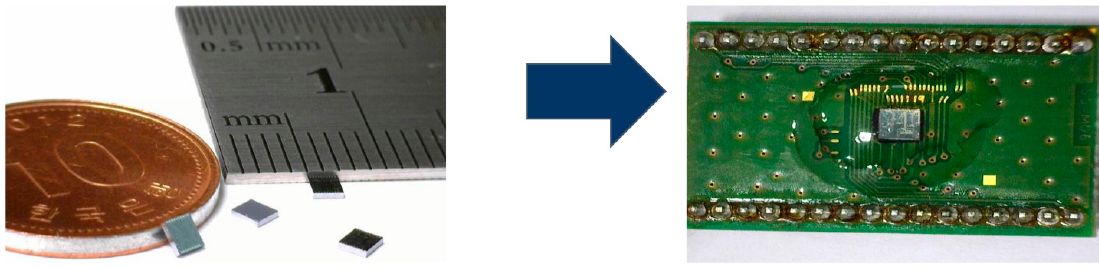
Figure 5. Photograph of diced multi-axis gyroscope and COB.